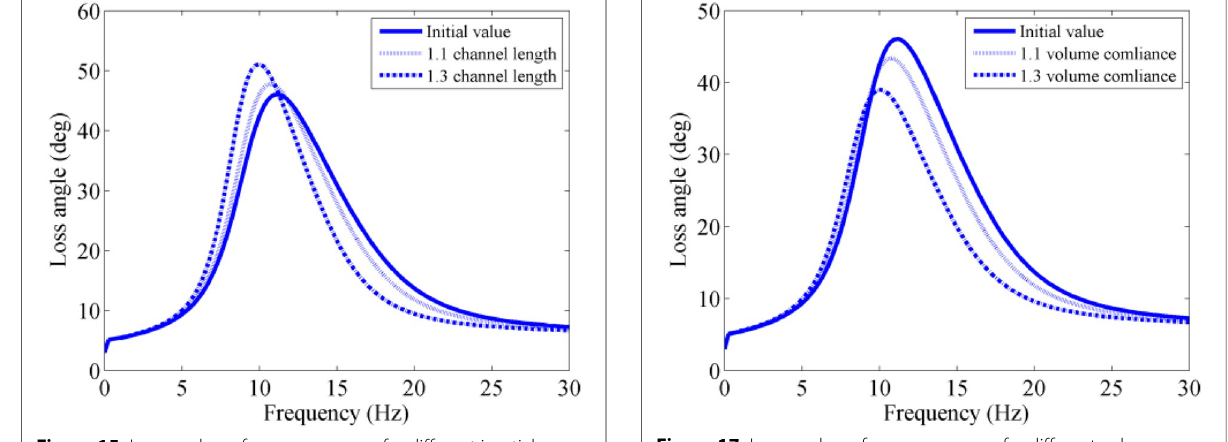
Figure 15 Loss angle vs. frequency curves for different inertial channel lengths